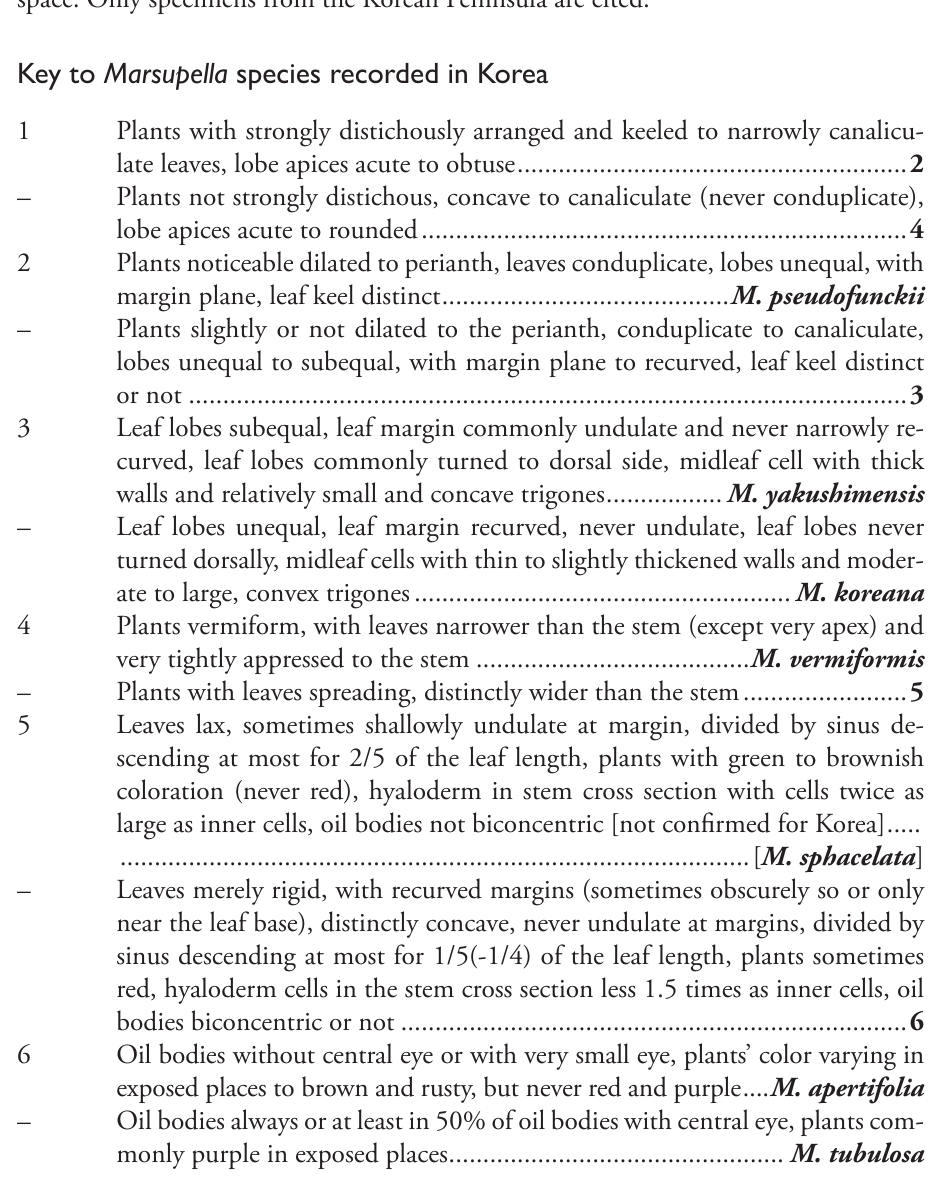
lobes unequal to subequal, with margin plane to recurved, leaf keel distinct Leaf lobes subequal, leaf margin commonly undulate and never narrowly re- curved, leaf lobes commonly turned to dorsal side, midleaf cell with thick Leaf lobes unequal, leaf margin recurved, never undulate, leaf lobes never turned dorsally, midleaf cells with thin to slightly thickened walls and moder- Plants vermiform, with leaves narrower than the stem (except very apex) and